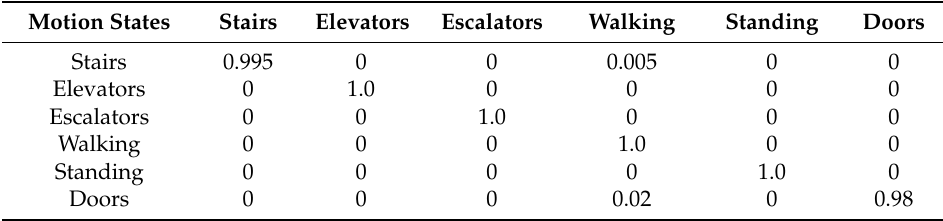
Table 2. Confusion matrix for landmarks